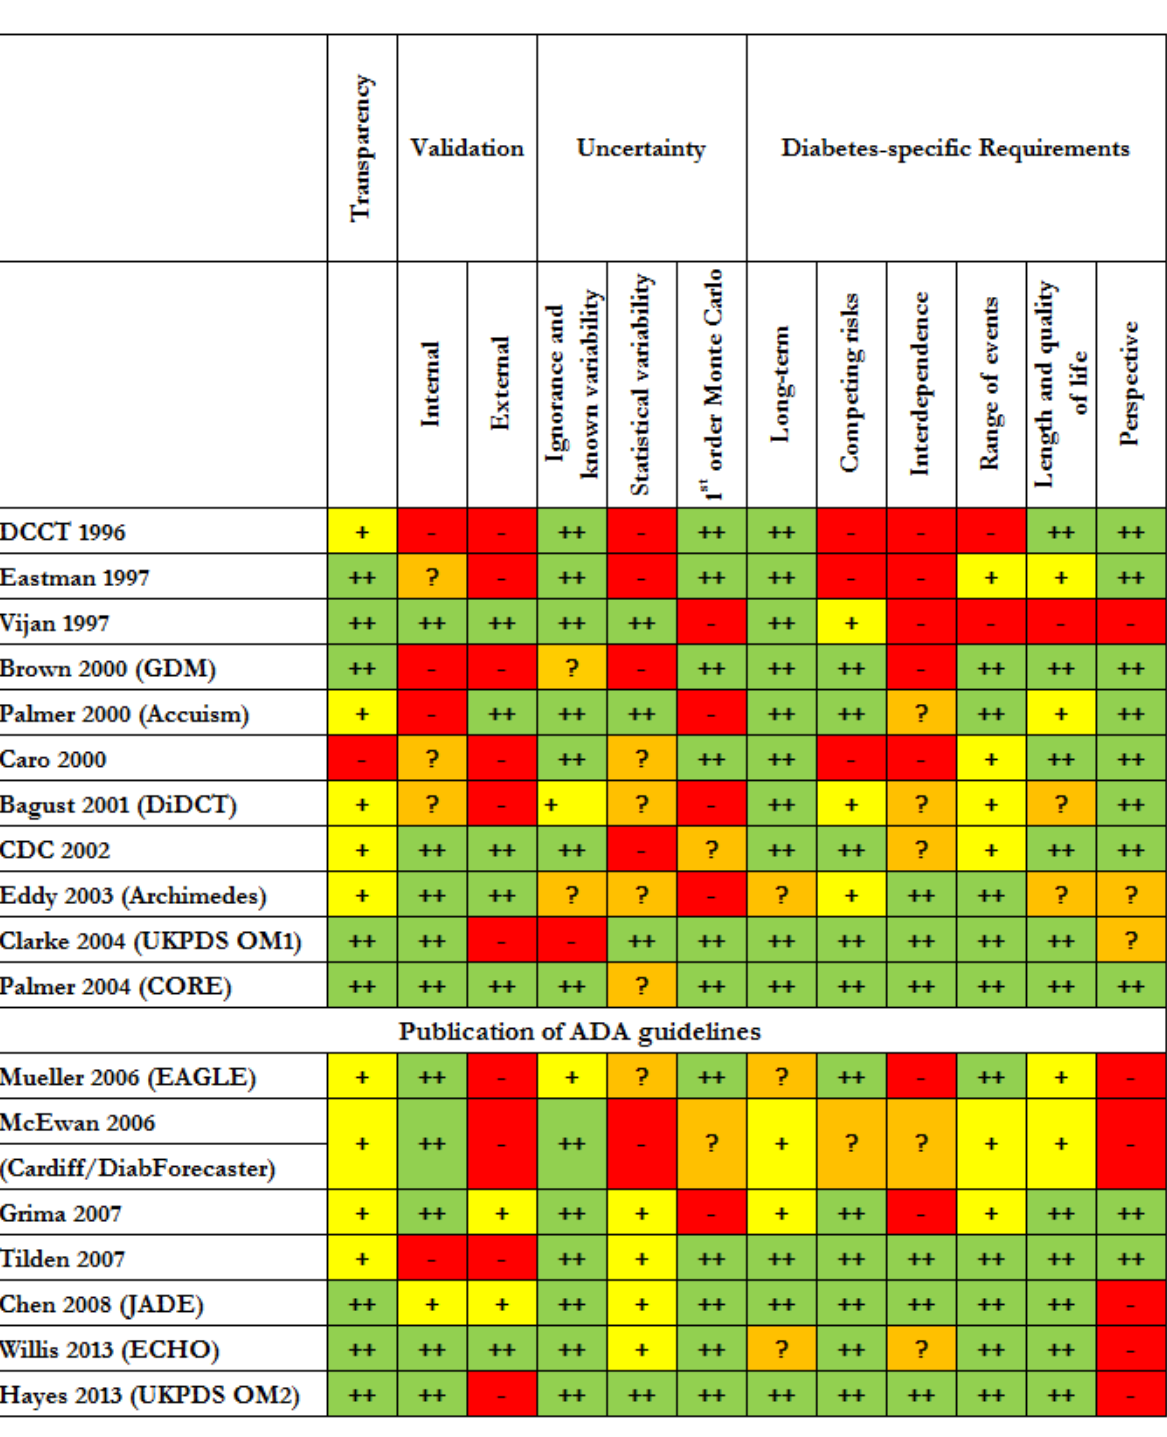
++ reported well; + partially reported; ? unclear reporting; - not